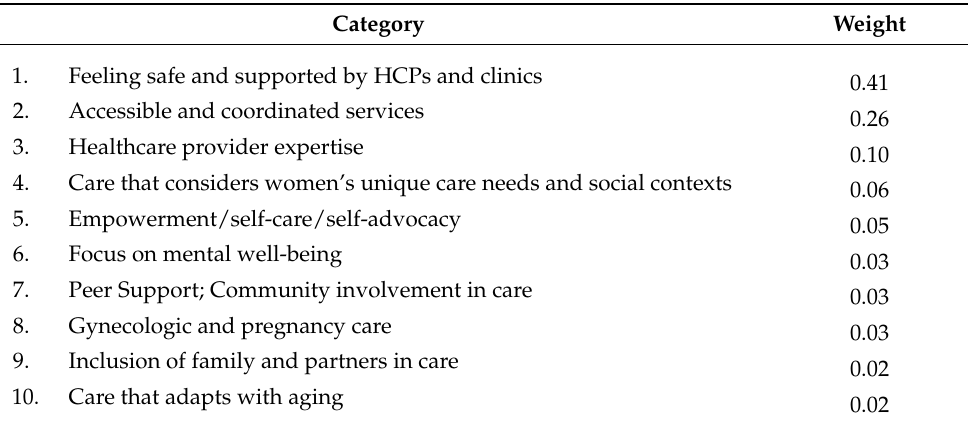
Table 3. Categories influencing women’s satisfaction with HIV care and their relative category weightings considering direct and indirect